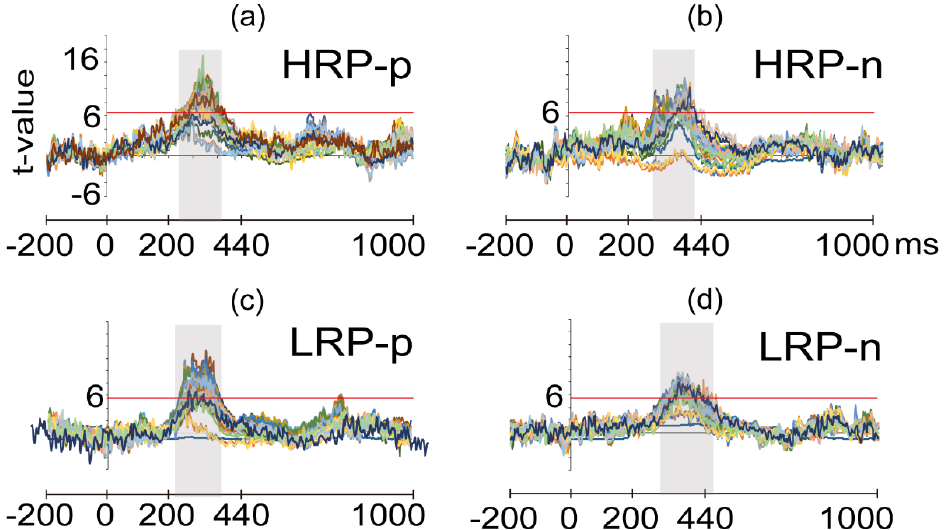
Figure 3. Event-related potentials of the Sternberg task. t-values across epochs (–200 to 1000 ms) of every electrode site (in various colors) resulting from the comparison between low and high WM loads for: ( a ) high reading performance group in the positive probes (HRP-p); ( b ) high reading performance group in the negative probes (HRP-n); ( c ) low reading performance group in the positive probes (LRP-p); ( d ) low reading performance in the negative probes (LRP-n). Red horizontal lines represent the threshold of significant t-values at p < 0.05. Gray shadow boxes indicate the time windows for significant amplitude differences.